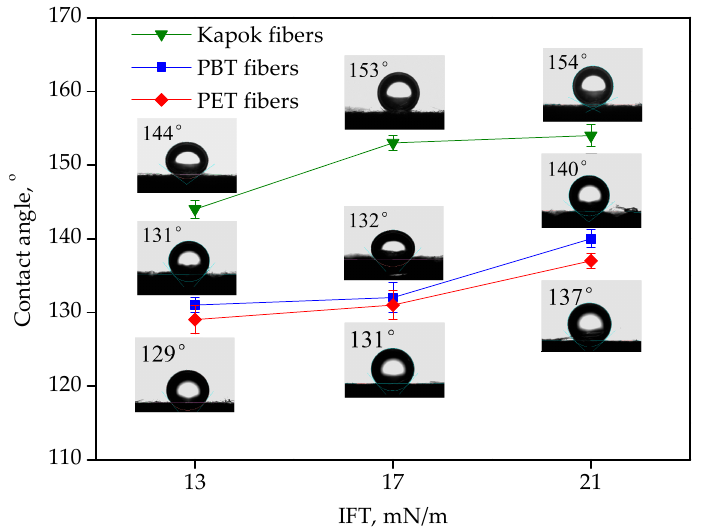
Figure 3. The contact angle of fibers under different interfacial tension (IFT).